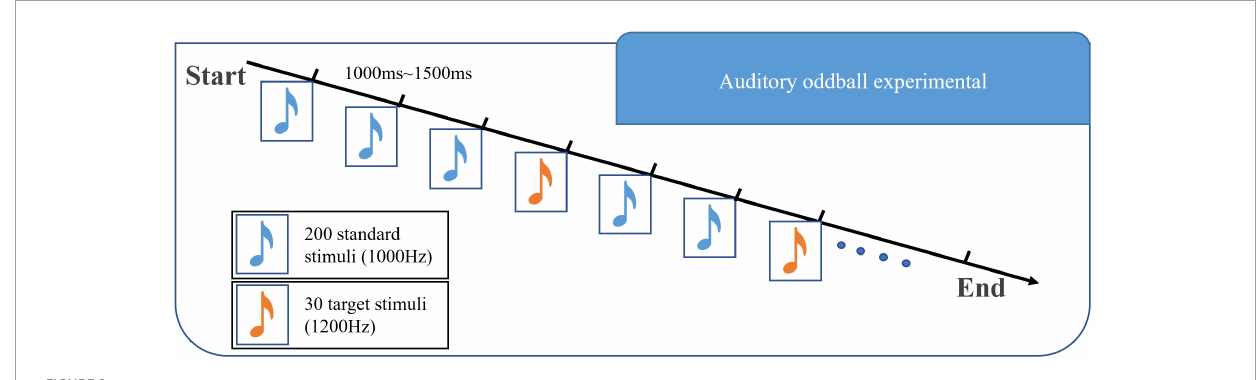
FIGURE2 Diagram of the experimental paradigm in this paper. This experimental paradigm includes two kinds of stimuli: 1,000 Hz majority stimulus and 1,200 Hz target stimulus. The stimuli are arranged in a pseudo-random manner, with an interval of 1,000–1,500 ms between each